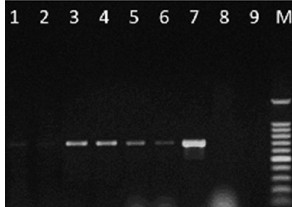
Figure 5. Specificity of PCR using the primer pair CLF / CLR for the detection of C. lupini in seed samples artificially infected (1:10,000). Lane 1–2 = L. albus cv. Multitalia, Lane 3–4 = L. luteus cv. Mister, Lane 5–6 = L. angustifolius cv. Tango, Lane 7 = Positive control ( C. lupini IMI 504893), Lane 8 = Seed control (100 seeds of L. angustifolius cv. Tango), Lane 9 = Negative control (without DNA), and Lane M = 100 bp DNA